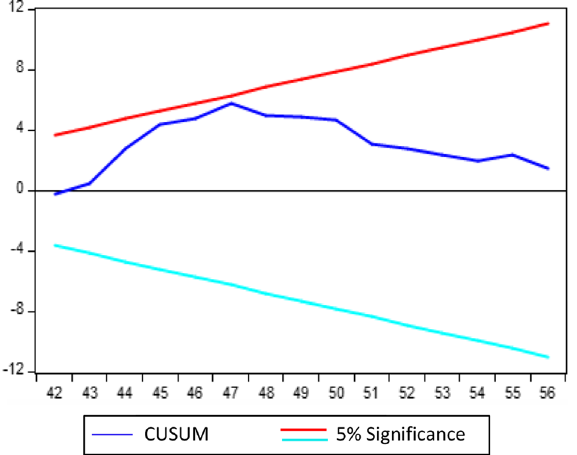
Fig. 9 Plot of Cumulative Sum of Recursive Residuals